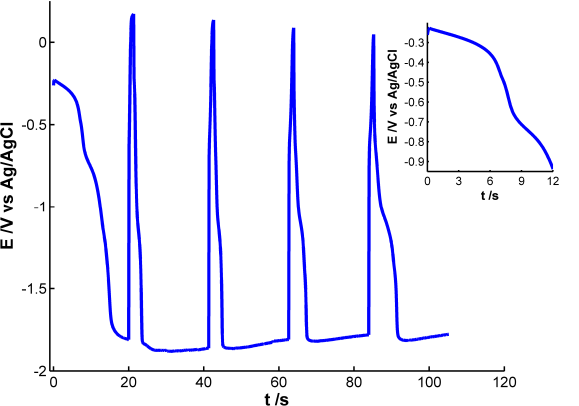
Figure 1. Chronopotentiogram obtained during the galvanostatic multipulse synthesis of AgNPs applying nine reduction/oxidation currents of −1 × 10 −4 A for 20 s and 1 × 10 −4 A for 1.3 s. (Inset: Zoom corresponding to the first 12 s of the galvanostatic experiment).